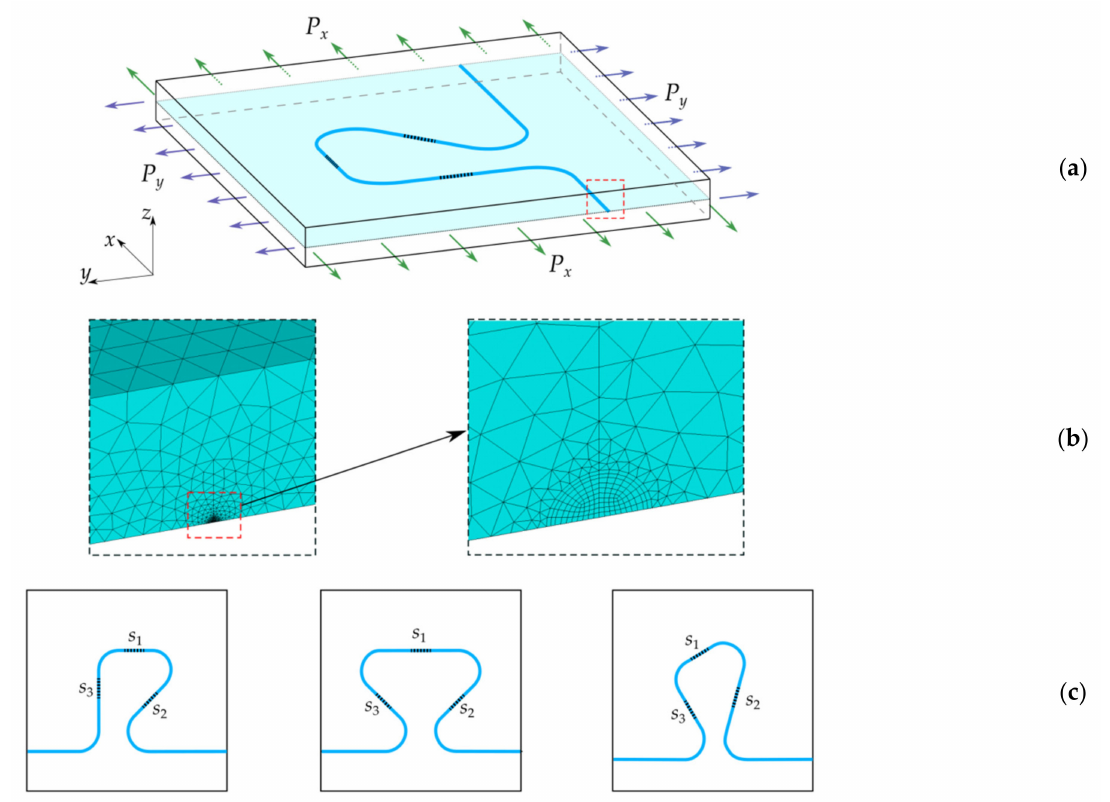
Figure 11. Calculation schemes for PCM with an embedded optical fiber forming a rosette of sensors ( a ), examples of discretization of a finite element mesh of the region near the optical fiber ( b ), options for sensor location in the rosette ( c